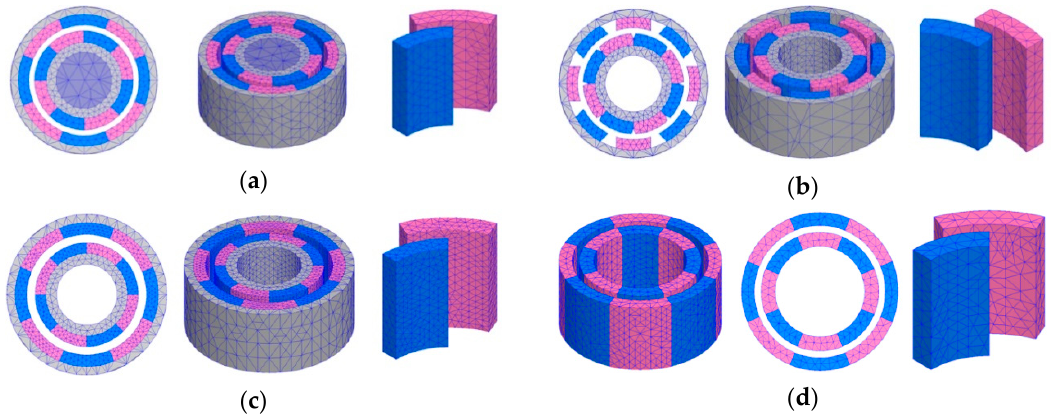
Figure 5. The Tetra mesh of all the configurations tested in MAXWELL are presented here: ( a ) mesh of Type A, ( b ) Type B, ( c ) Type C, and ( d ) Type D.